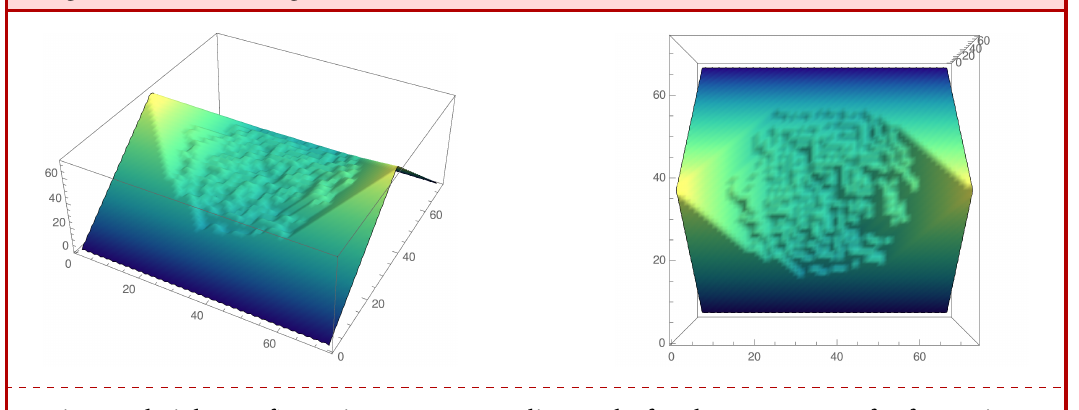
Discrete height configuration on a Aztec diamond of order L = 72. Left: front view. Right: top view. The average height is of order L , while fluctuations are of order ≈ log L , as